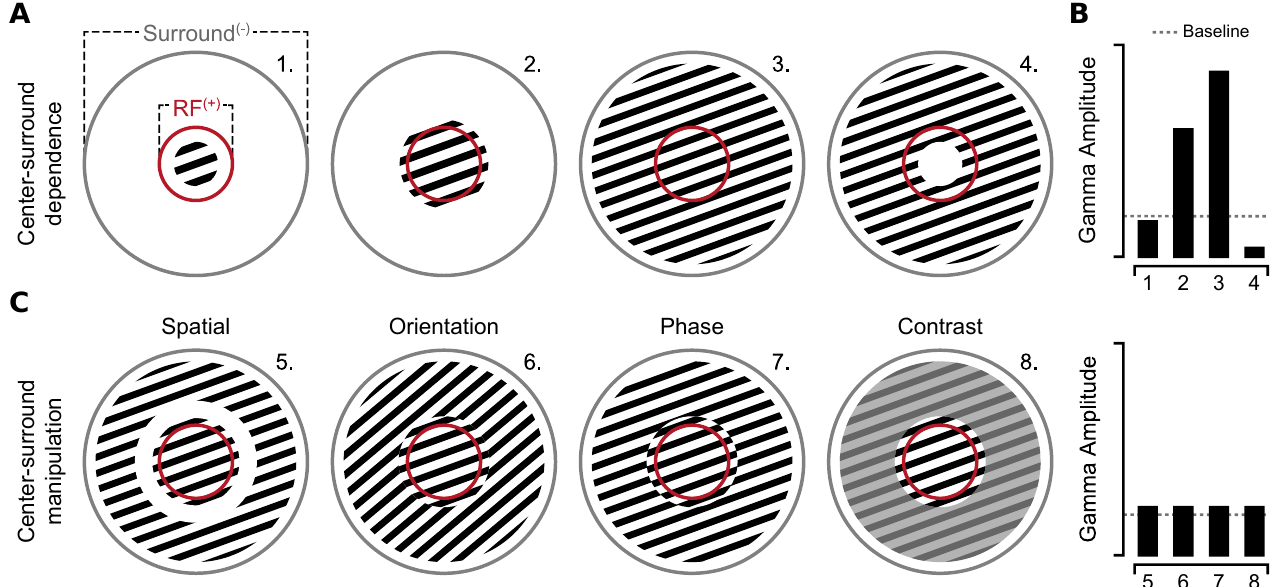
Fig 1. RF center-surround factors that influence gamma amplitude. ( A ) Simplified schematic depiction of RF center (+ excitatory) and surround ( − inhibitory), with related changes in gamma amplitude shown in ( B ; upper). High contrast gratings smaller than the RF center do not induce gamma oscillations beyond baseline levels (1). Grating stimuli must extend through the RF center to increase gamma amplitude (2), which is maximally driven when coherently falling on both RF and surround (3). Gratings that predominately fall on the surround and not the RF center will reduce gamma amplitude below baseline levels (4; likely due to a predominance of inhibition without RF excitatory drive) [6]. ( C ) Grating center-surround manipulations performed by Shirhatti and colleagues (2). Even if grating stimuli fall upon both RF center and surround, small spatial (5), orientation (6), phase (7) or contrast (8) discontinuities between the center-surround greatly attenuate gamma amplitude (B; lower) from levels observed for contiguous gratings of the same size (3). RF, receptive field.